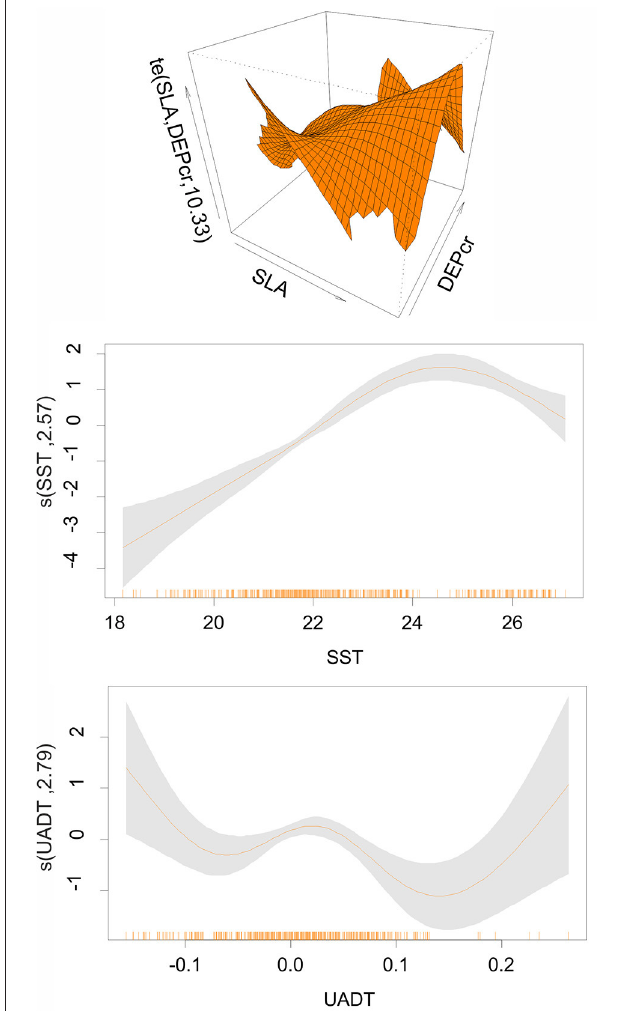
FIGURE 2 | Pooled model: Coefficients of the Generalized Additive Models (GAMs) for Atlantic Mackerel juveniles in summer period (June-July). SST, Sea Surface Temperature (oC); SLA, Sea Level Anomaly (in cm); DEPcr, Bottom Depth (in m); UADT, surface eastward geostrophic sea water velocity in ms − 1 . The interaction plots are also shown. Thick lines indicate the value of GAMs coefficient. Shadowed areas represent the confidence intervals at p = 0.01. The rug under the single variable effects plots indicates the density of points for different variable